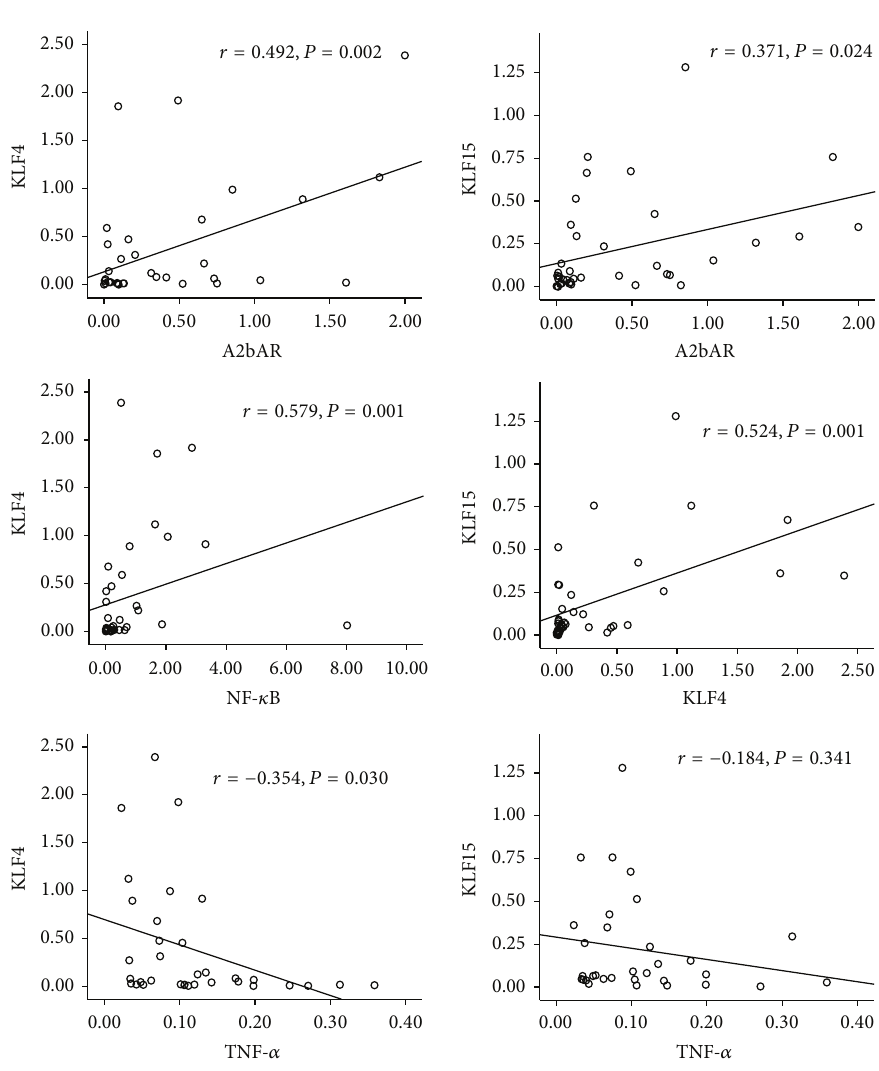
Figure 3: The correlation of KLF4 , KLF15, and the key genes of inflammation signal pathway. Pearson analysis, 𝑃 < 0.05 . The correlation between the two groups has statistical